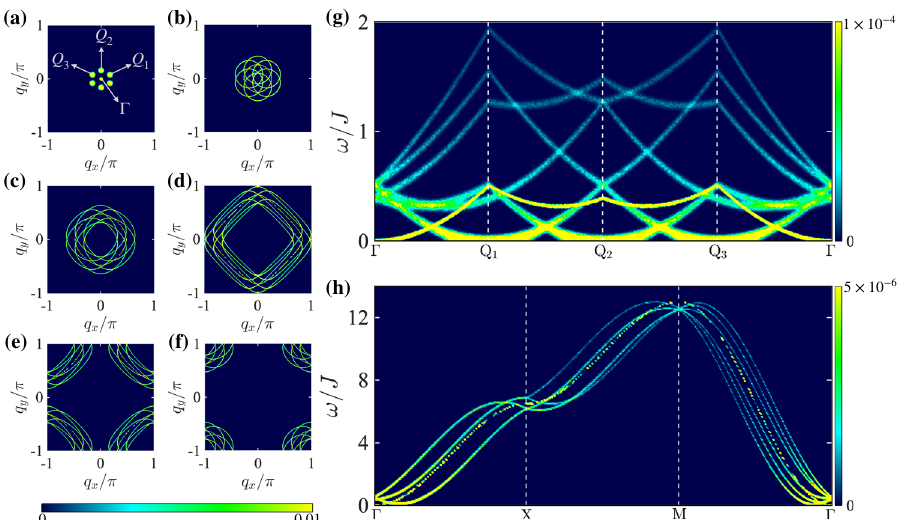
Fig. 2 Spin waves in the skyrmion crystal (SkX) phase. a – f Constant-energy contours of the dynamical spin structure factor S ( q , ω ) calculated in the momentum plane q = ( q x , q y ) in the SkX phase, realized at a magnetic fi eld H z = 0.18 J ( ≈ 3.74 T), at energies a ω = 0, b ω = J , c ω = 3 J , d ω = 6 J , e ω = 8 J , and f ω = 11 J . Plot a shows the three characteristic momenta Q 1 , Q 2 , and Q 3 of the SkX. g , h Plots of S ( q , ω ) along the momentum paths g Γ − Q 1 − Q 2 − Q 3 − Γ and h Γ − X − M − Γ . The spin-wave mode originating from the Γ (0,0) point is due to the ferromagnetic background in the SkX. The rest six branches arise from the triangular SkX spin con fi guration.